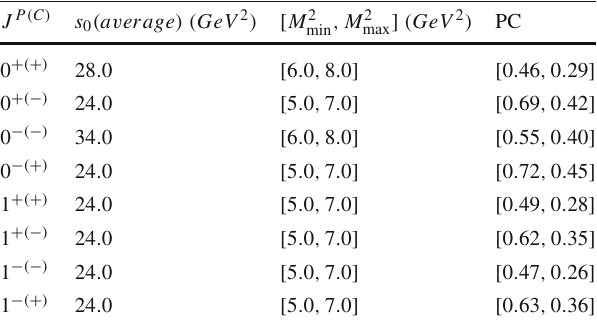
Table 2 Values of PC for different quantum numbers of the ground state charm-strange hybrid